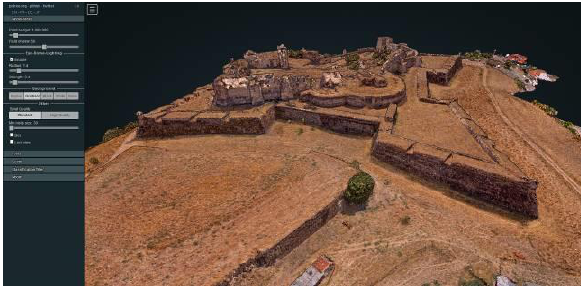
Figure 12. Online point cloud using Potree platform.